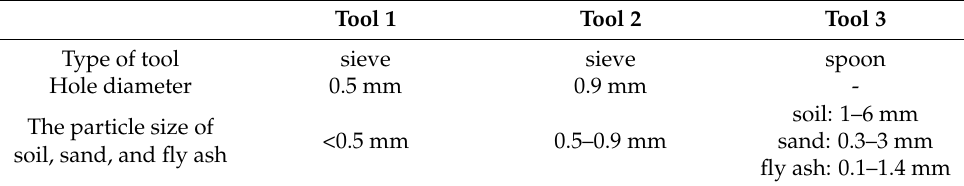
Table 4. Relationship between sprinkling tools and contaminants used in the tests.